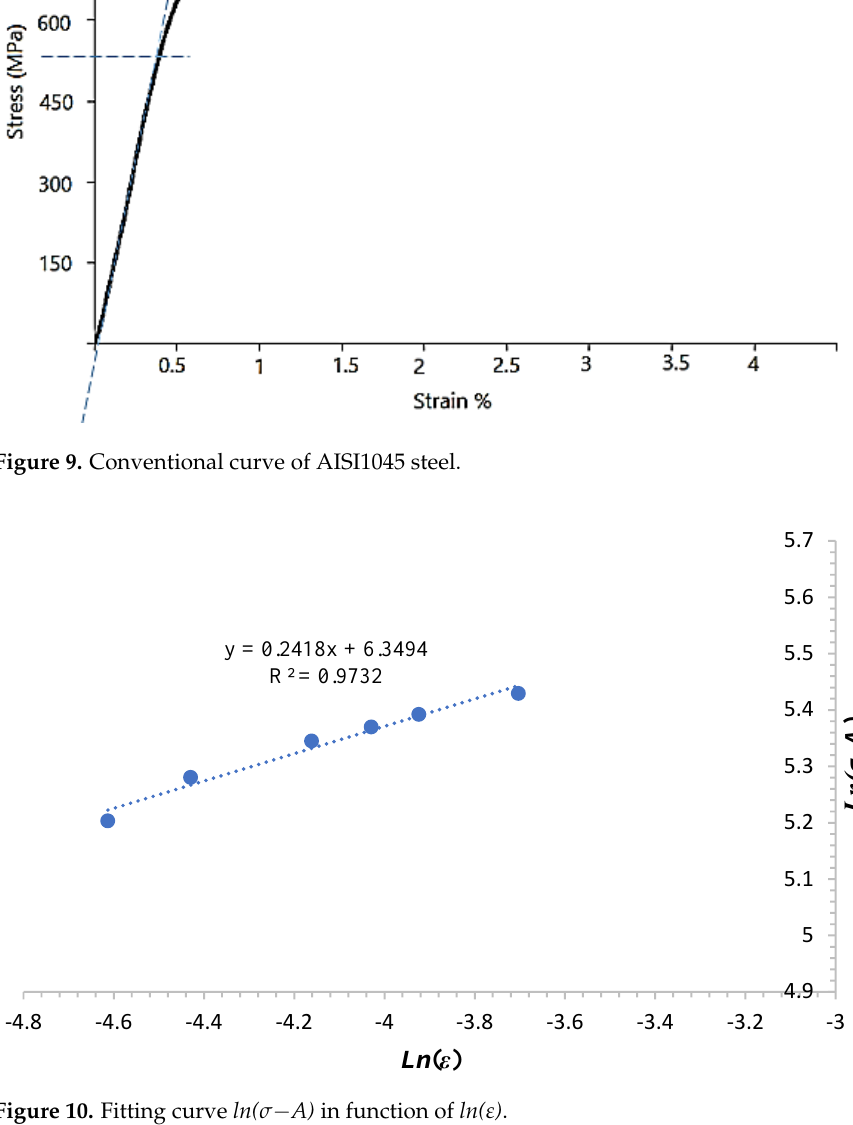
Figure 10. Fitting curve ln (σ − A) in function of ln(ε) .